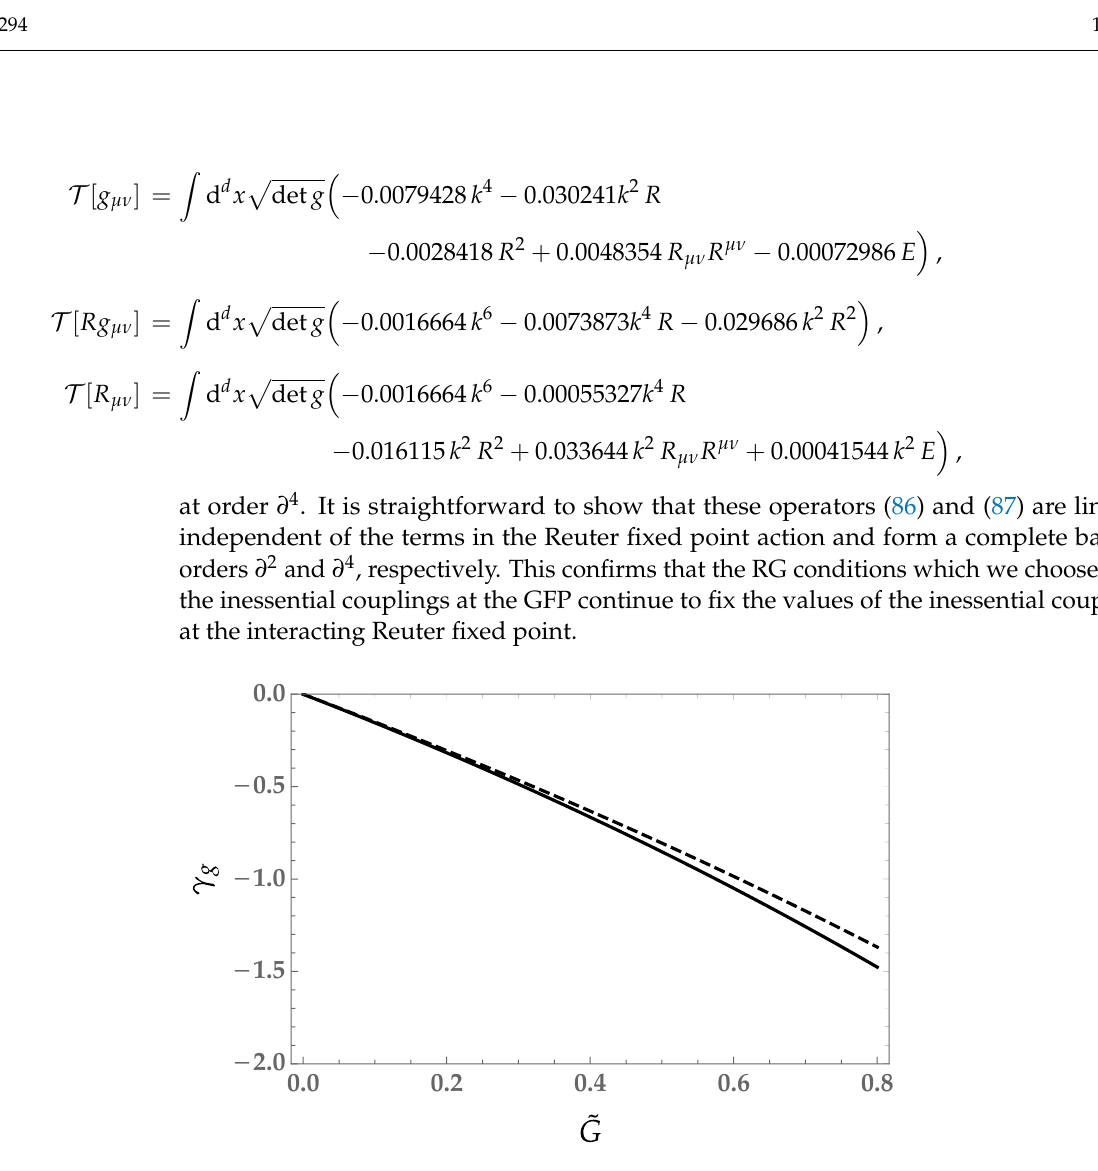
Figure 2. The gamma function γ g in the Einstein–Hilbert approximation (dashed line) and the order ∂ 4 approximation (solid line).